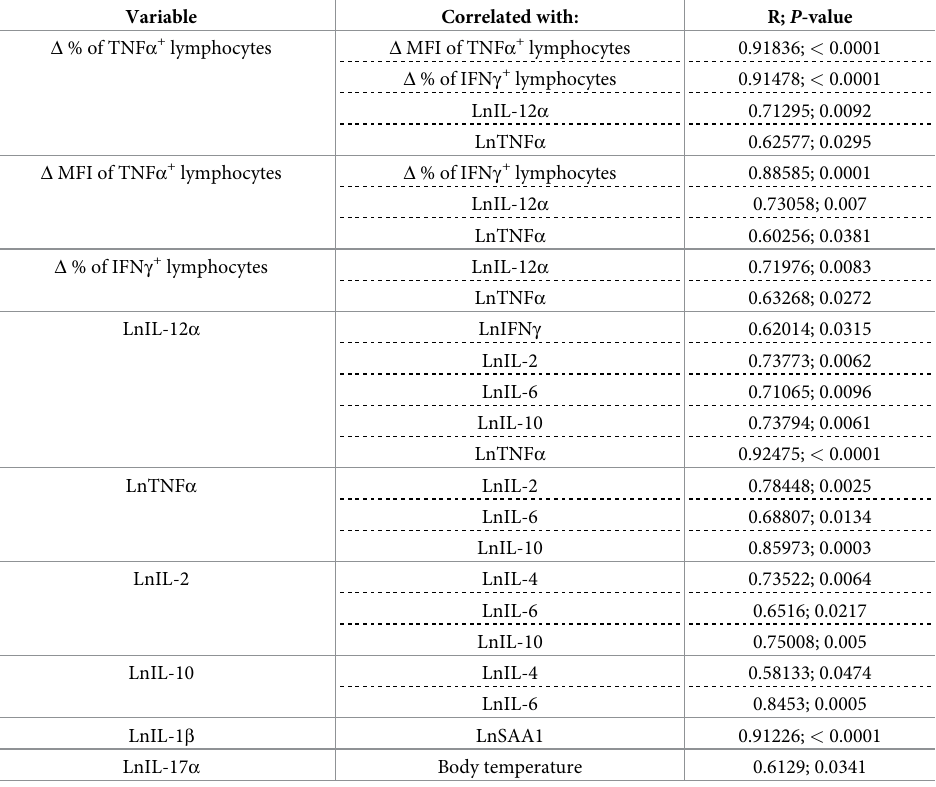
Table 1. Significant correlations at 15-min post-transport